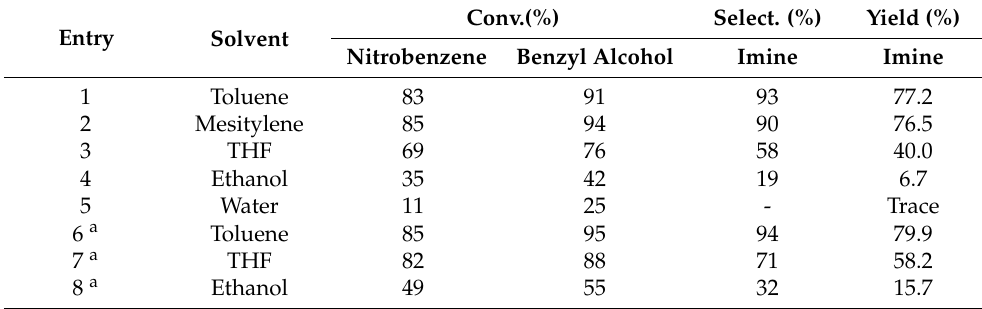
Table 2. The performances of photocatalytic synthesis of N -benzylideneaniline in various solvents.